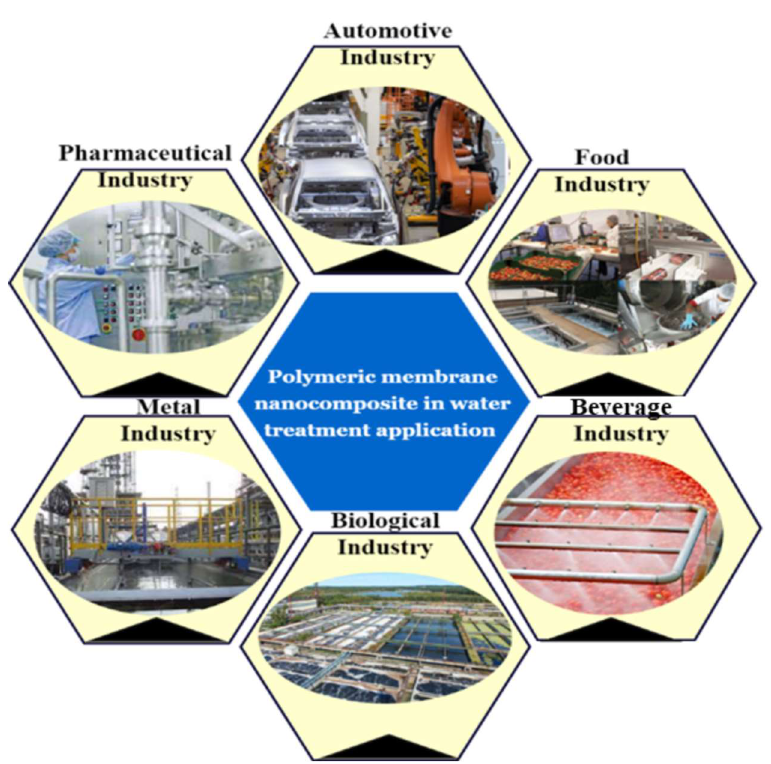
Figure 5. Schematic illustration of water treatment application.